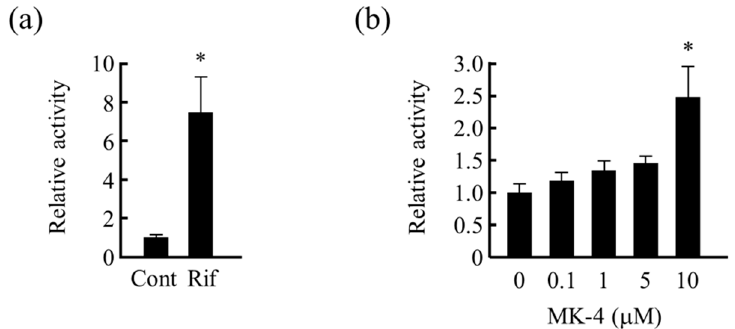
Figure 2. Effect of rifampicin (Rif) and menaquinone-4 (MK-4) on MDR1/pGL4-TK reporter gene activity. To determine the transcriptional activation of PXR by MK-4, the effects of ( a ) Rif and ( b ) different concentrations of MK-4 on MDR1/pGL4-TK reporter gene activity in LS180 cells were analyzed. Data are expressed as the mean ± standard error of the mean, n = 3, * p < 0.05 vs. control (Cont) ( a ) or MK-4 (0 μ M) ( b ). MDR1 , multi-drug resistance.